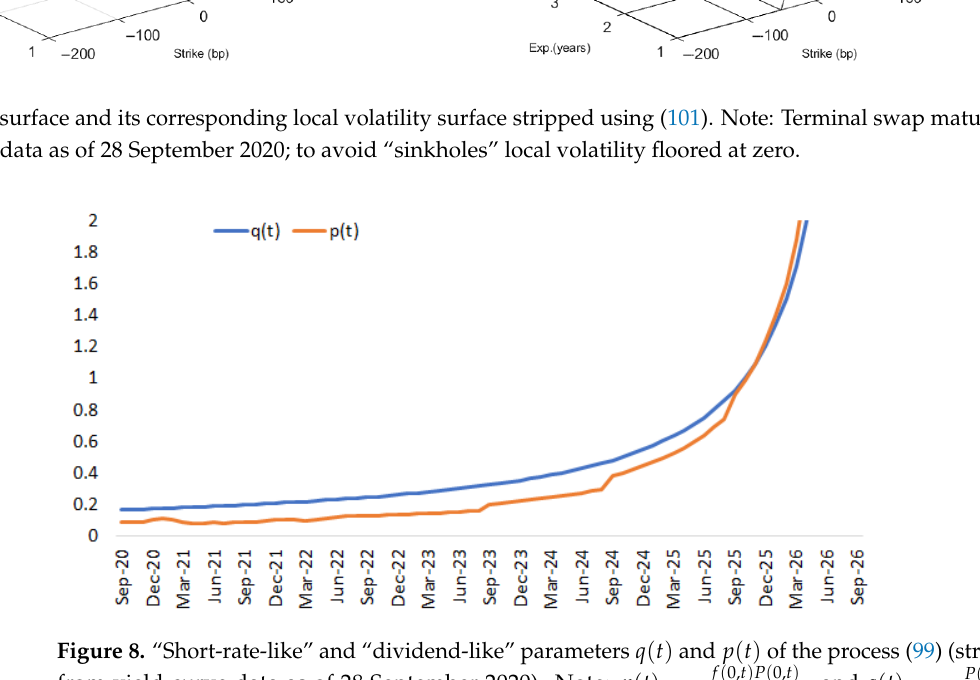
( 0, t ) P ( 0, t ) ( 0, t ) and q ( t ) = P , (cid:82) T P ( 0, t ) − P ( 0, T ) P ( 0, s ) ds t